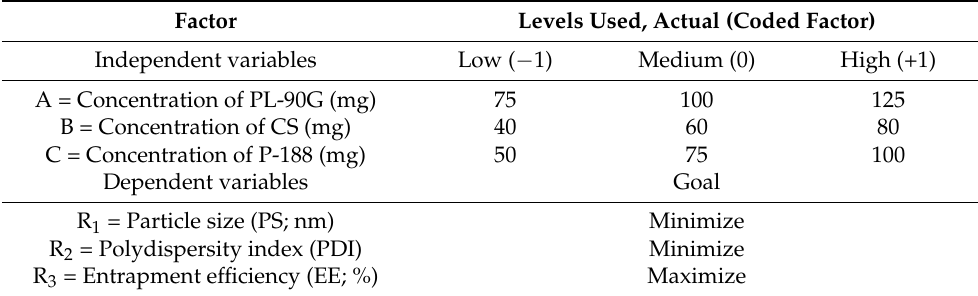
Table 1. Selected independent and dependent variables that were used to optimize PPN-LPHNPs by the 3 3 -BBD. Factor Levels Used, Actual (Coded Factor) Independent variables Low ( −